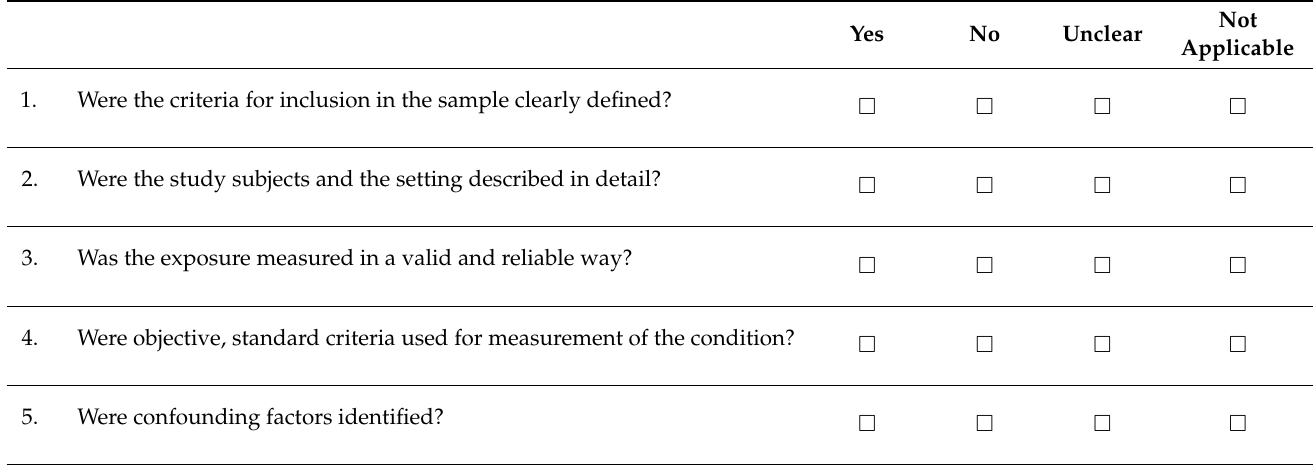
Table A1. JBI Critical Appraisal Checklist for Analytical Cross-Sectional